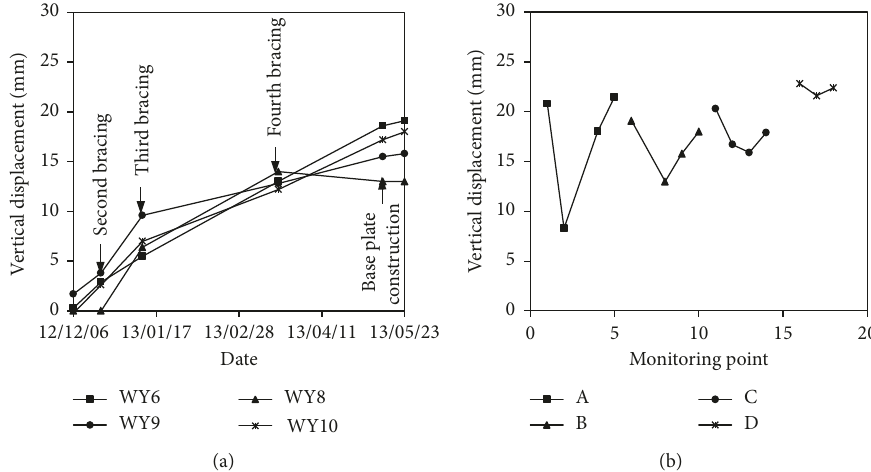
Figure 6: Vertical displacement of diaphragm wall top at B side. (a) Time curves of diaphragm wall top at B side. (b) Curves when finishing base plate